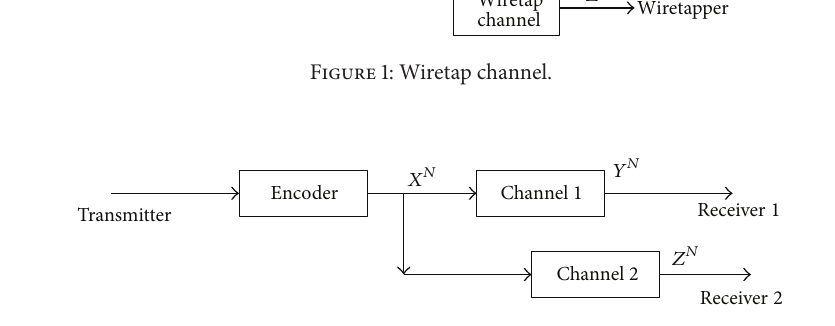
Figure 2: Broadcast channels with confidential messages.